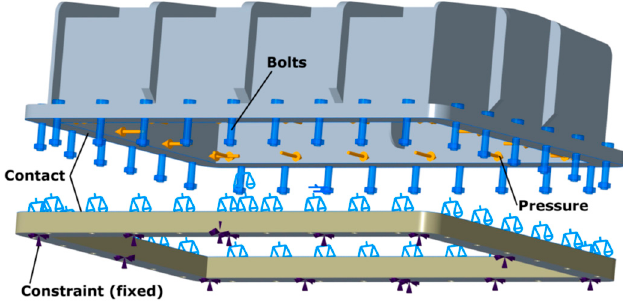
Figure 8. Computational model of the top cover assembly.